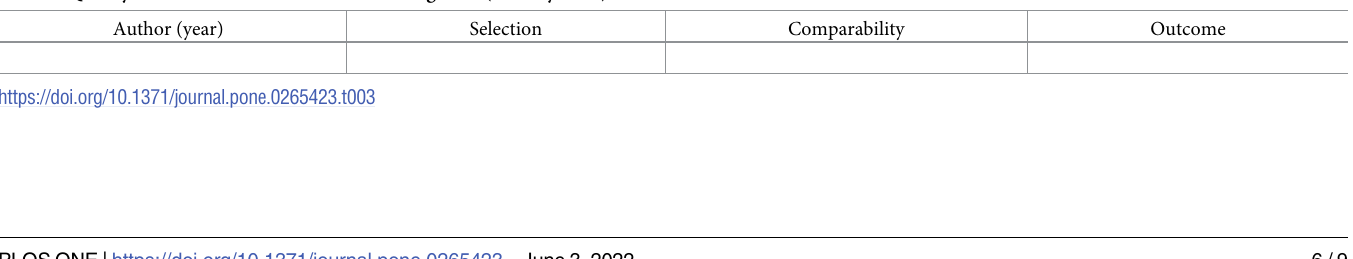
Table 3. Quality assessment of included studies using NOS (dummy